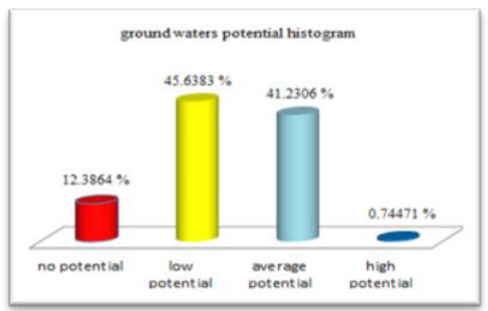
Figure 9. Ground waters potential